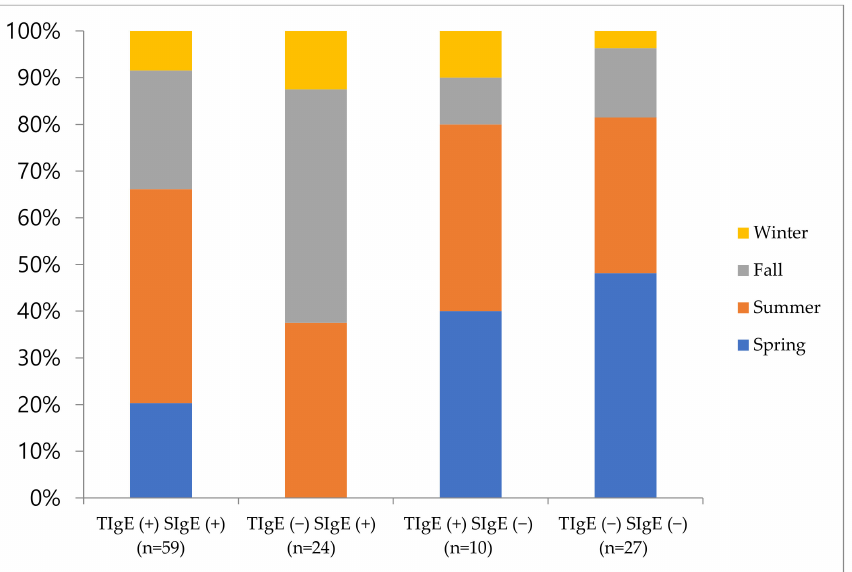
Figure 2. Seasonal distribution of each subgroup according to the detection of serum total im- munoglobulin E and serum specific immunoglobulin E. TIgE, serum total immunoglobulin E; SigE, serum specific immunoglobulin